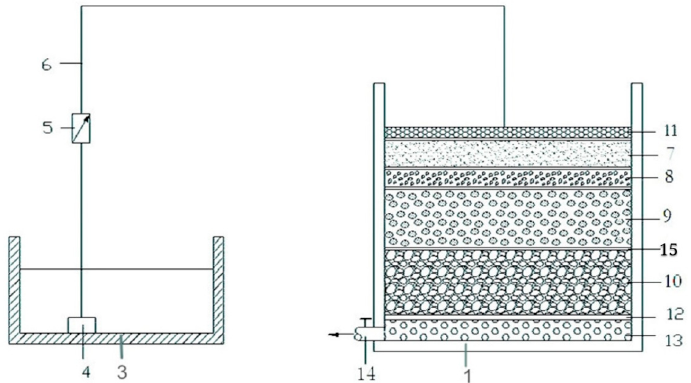
Figure 1. Infiltration pool and water intake diagram 1–pool with pumice synthetized guar gum-nanoscale zerovalent iron beads (PPG-nZVI beads) layer; 2–pool without PPG-nZVI beads layer (not shown in the figure); 3–reservoir; 4–water pump; 5–flowmeter; 6–water pipes; 7–sand layer; 8–sawdust layer; 9–pumice layer; 10–fine gravel layer; 11–PPG-nZVI beads layer; 12–partition; 13–pebble support layer; 14–outlet; 15–geotextile.